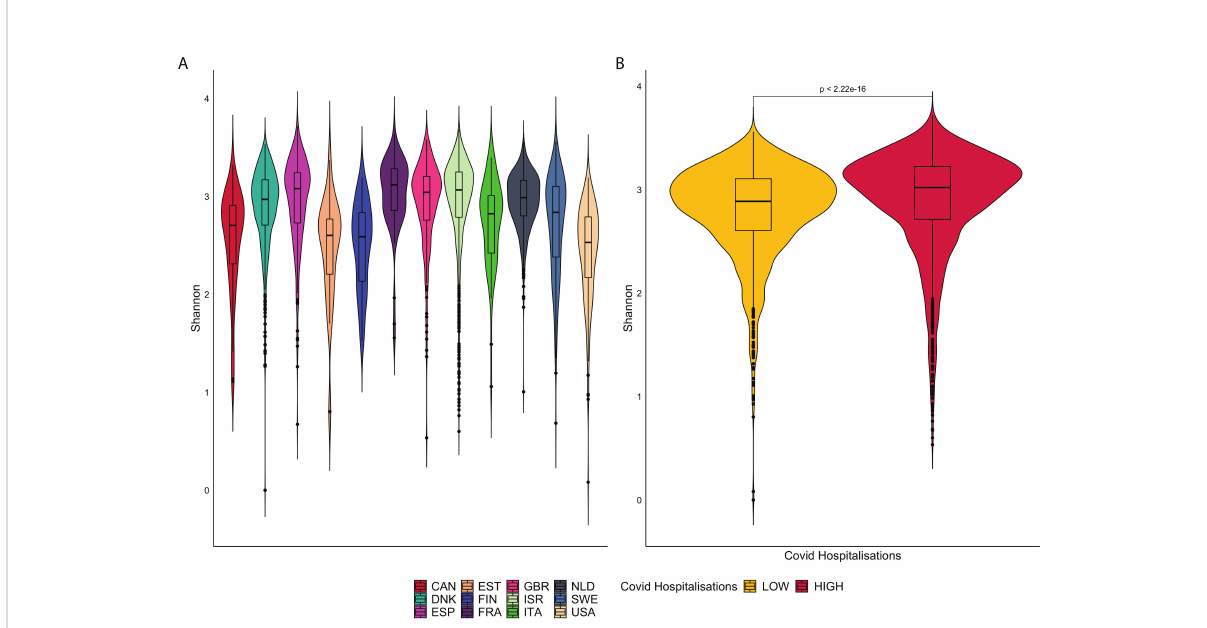
FIGURE 3 (A) is a representation of violin plots based on the Shannon alpha diversity index for each country. (B) displays violin plots based on Low and High COVID-19 groups with corresponding